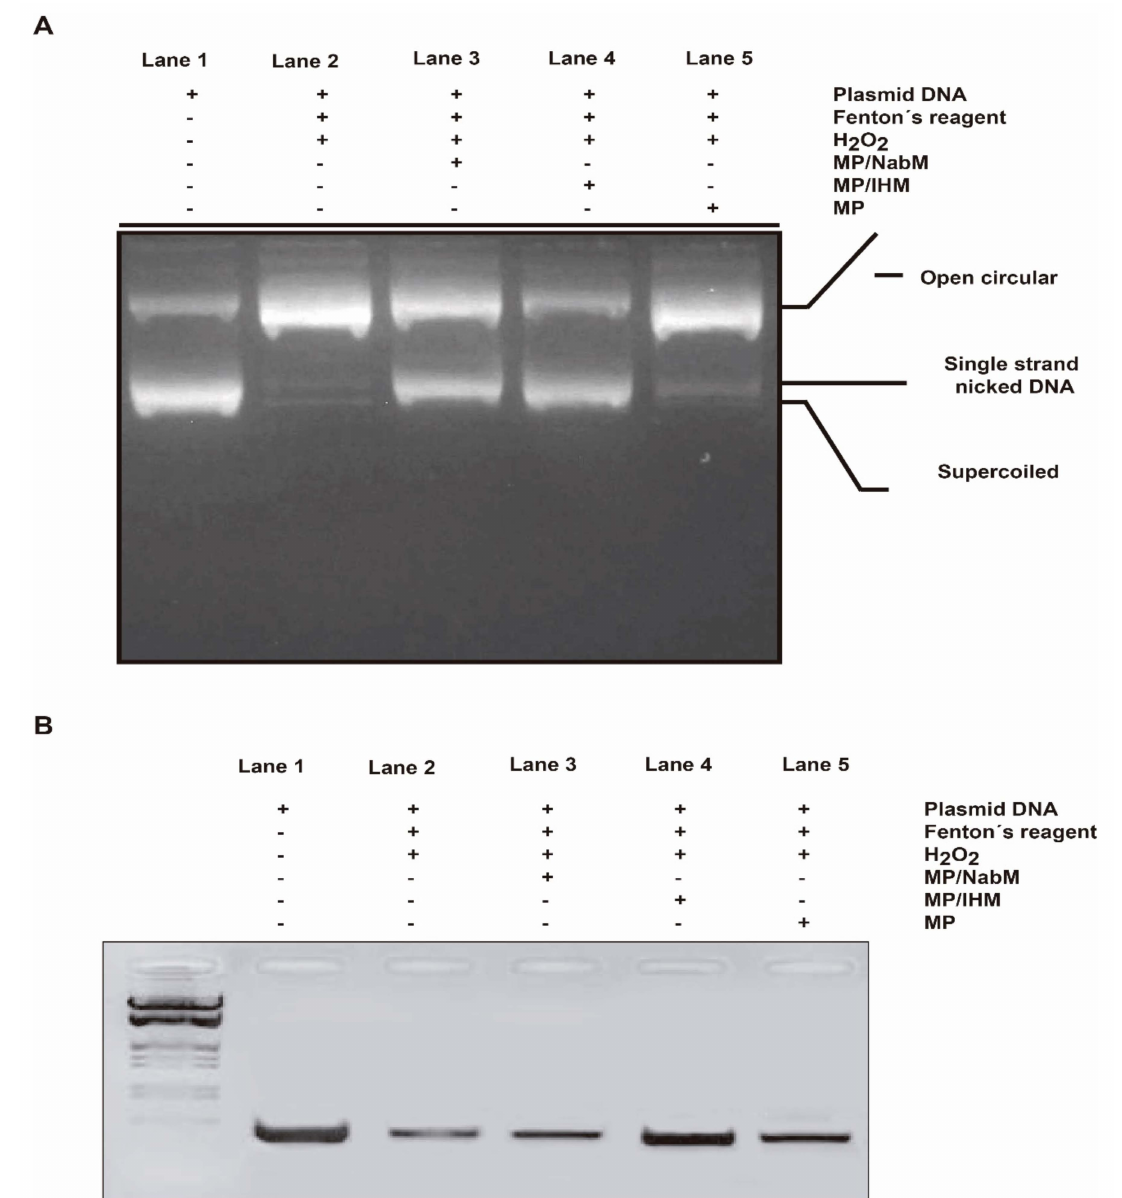
Figure 9. DNA damage protection by MP/NabM and MP/IHM. ( A ) The protective capacity MP/NabM, MP/IHM, and MP against RNH1 plasmid DNA damage induced by Fenton’s reagent. ( B ) The protective capacity MP/NabM, MP/IHM, and MP against genomic DNA damage. Lane 1: DNA control, lane 2: DNA treated with Fenton’s reagent, lane 3: DNA treated with Fenton’s reagent plus MP/NabM, lane 4: DNA treated with Fenton’s reagent plus MP/IHM, and lane 5: DNA treated with Fenton’s reagent plus MP. MP: milk proteins concentrate; MP/NabM: milk proteins/Nabeq mucilage complex; MP/IHM: milk proteins/Isabgol husk mucilage